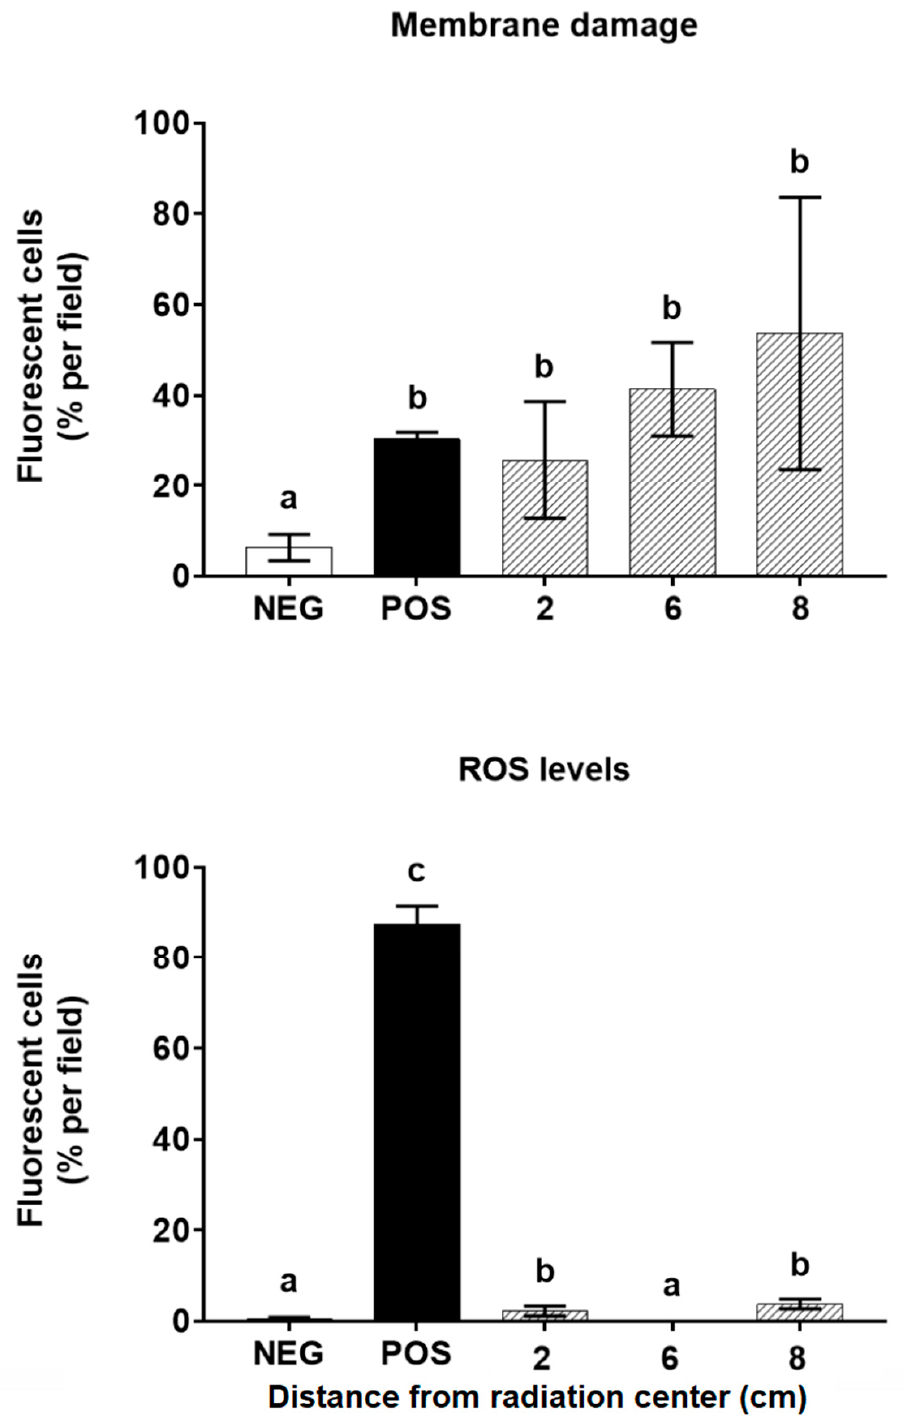
Figure 4. Evaluation of cell damage in S. cerevisiae EC1118 after exposure for 15 min to a 5.9 GHz band at different distances from the antennas. The membrane damage and ROS levels were measured using the percentage of fluorescent yeasts obtained after staining with propidium iodide (PI) and 6-carboxy-2’,7’-dichlorodihydrofluorescein diacetate (C400), respectively. White bars (labeled NEG) correspond to untreated cells (negative control), while black bars (labeled POS) correspond to yeasts treated with zymolyase (600 µ g/mL) before exposure to H 2 O 2 30% v / v for 30 min (positive control). Bars in striped lines correspond to exposure distances (cm) from the antennas. Different letters above each bar represent a statistical difference between the treatments ( p <